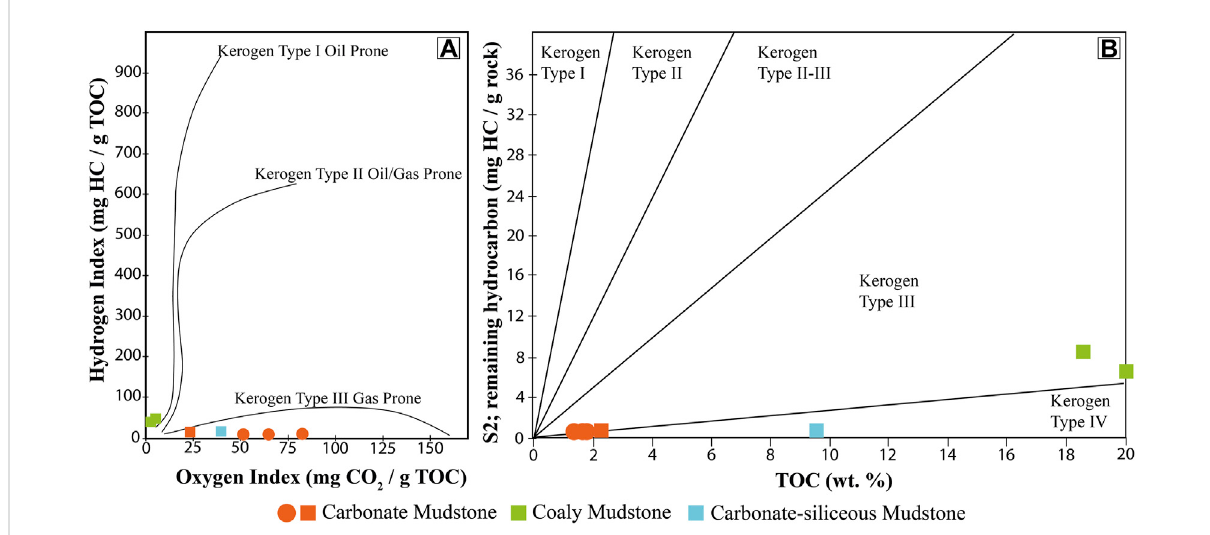
FIGURE 7 (A) Modi fi ed van Krevelen diagram of the hydrogen index and oxygen index showing the kerogen quality of the studied samples. (B) Cross-plot of total organic carbon (TOC) and remaining hydrocarbon potential (S2) showing the quality of kerogen in the studied samples. The red rectangle, green rectangle, and blue rectangle represent the samples from location A, while the red dot denotes the samples from location